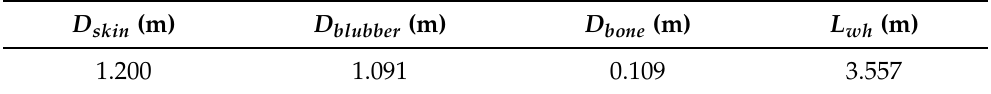
Table 3. Geometrical properties of the numerical model of the killer